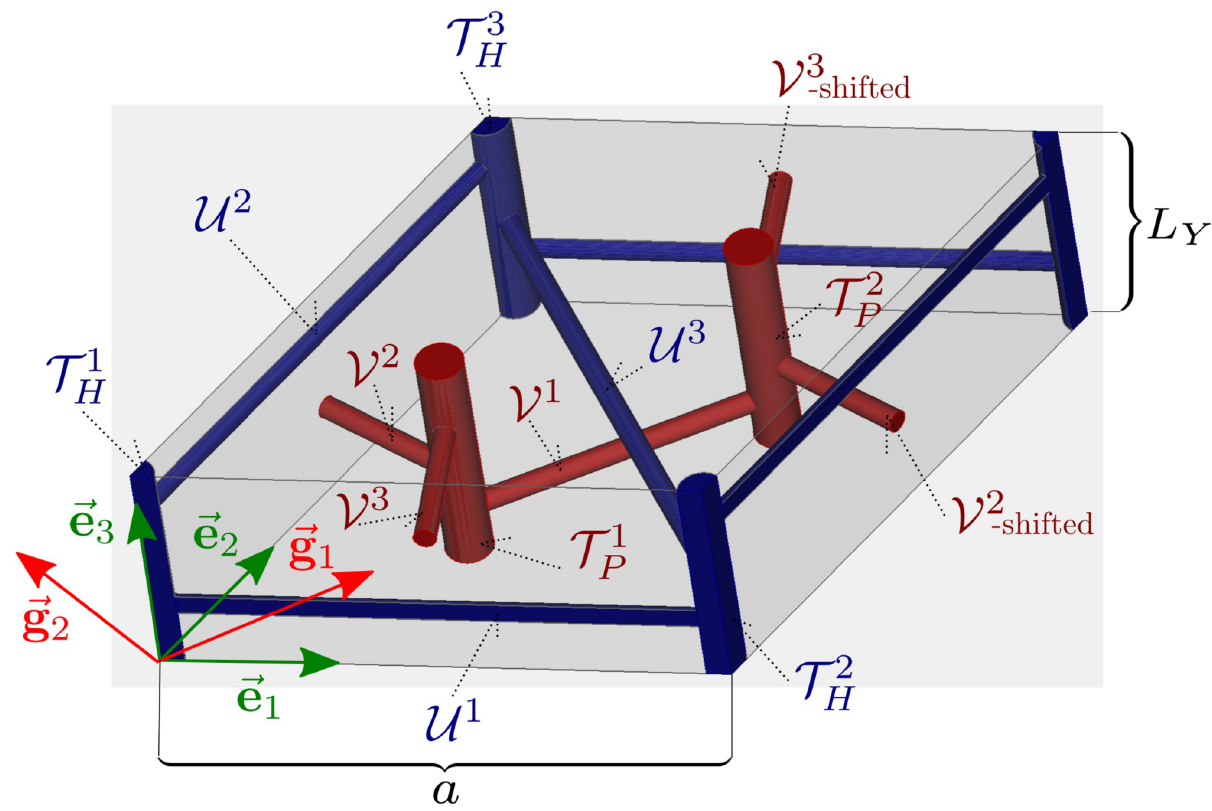
Fig 2. The LRPC geometry with descriptions of the PV and HV tracks connected with the central and vertex veins of the lobule.